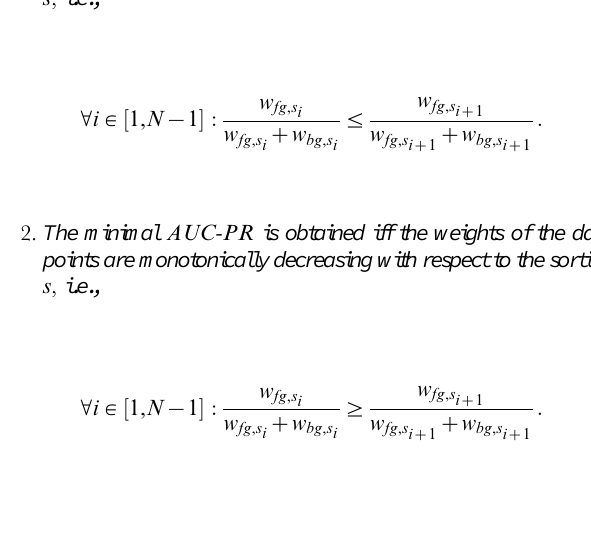
Table 3. Algorithm 1: Pseudo code for computing the AUC-PR based on the continuous interpolation.